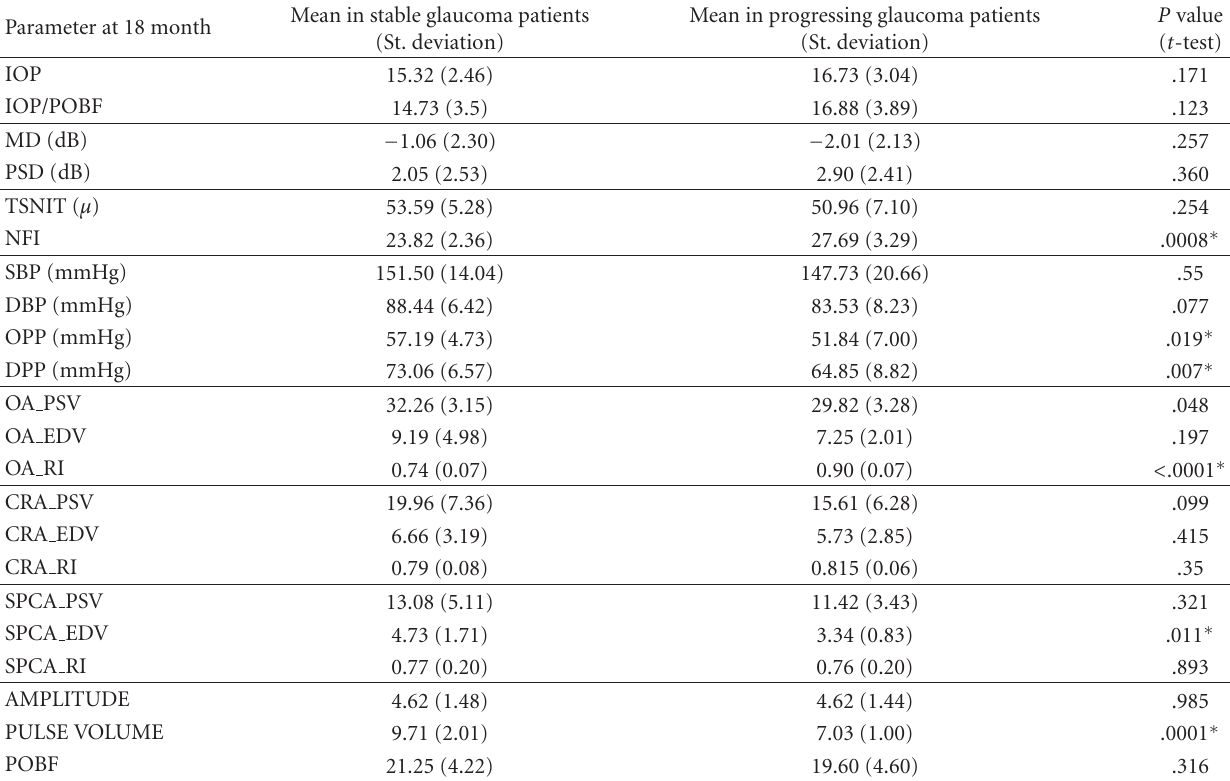
Table 4: Comparison of means between progressing and stable glaucoma patients at 18 months